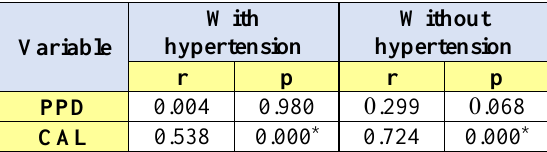
Table 5: Correlation coefficients between plaque index, with probing pocket depth and clinical attachment level, among groups of patients with and without hypertension.